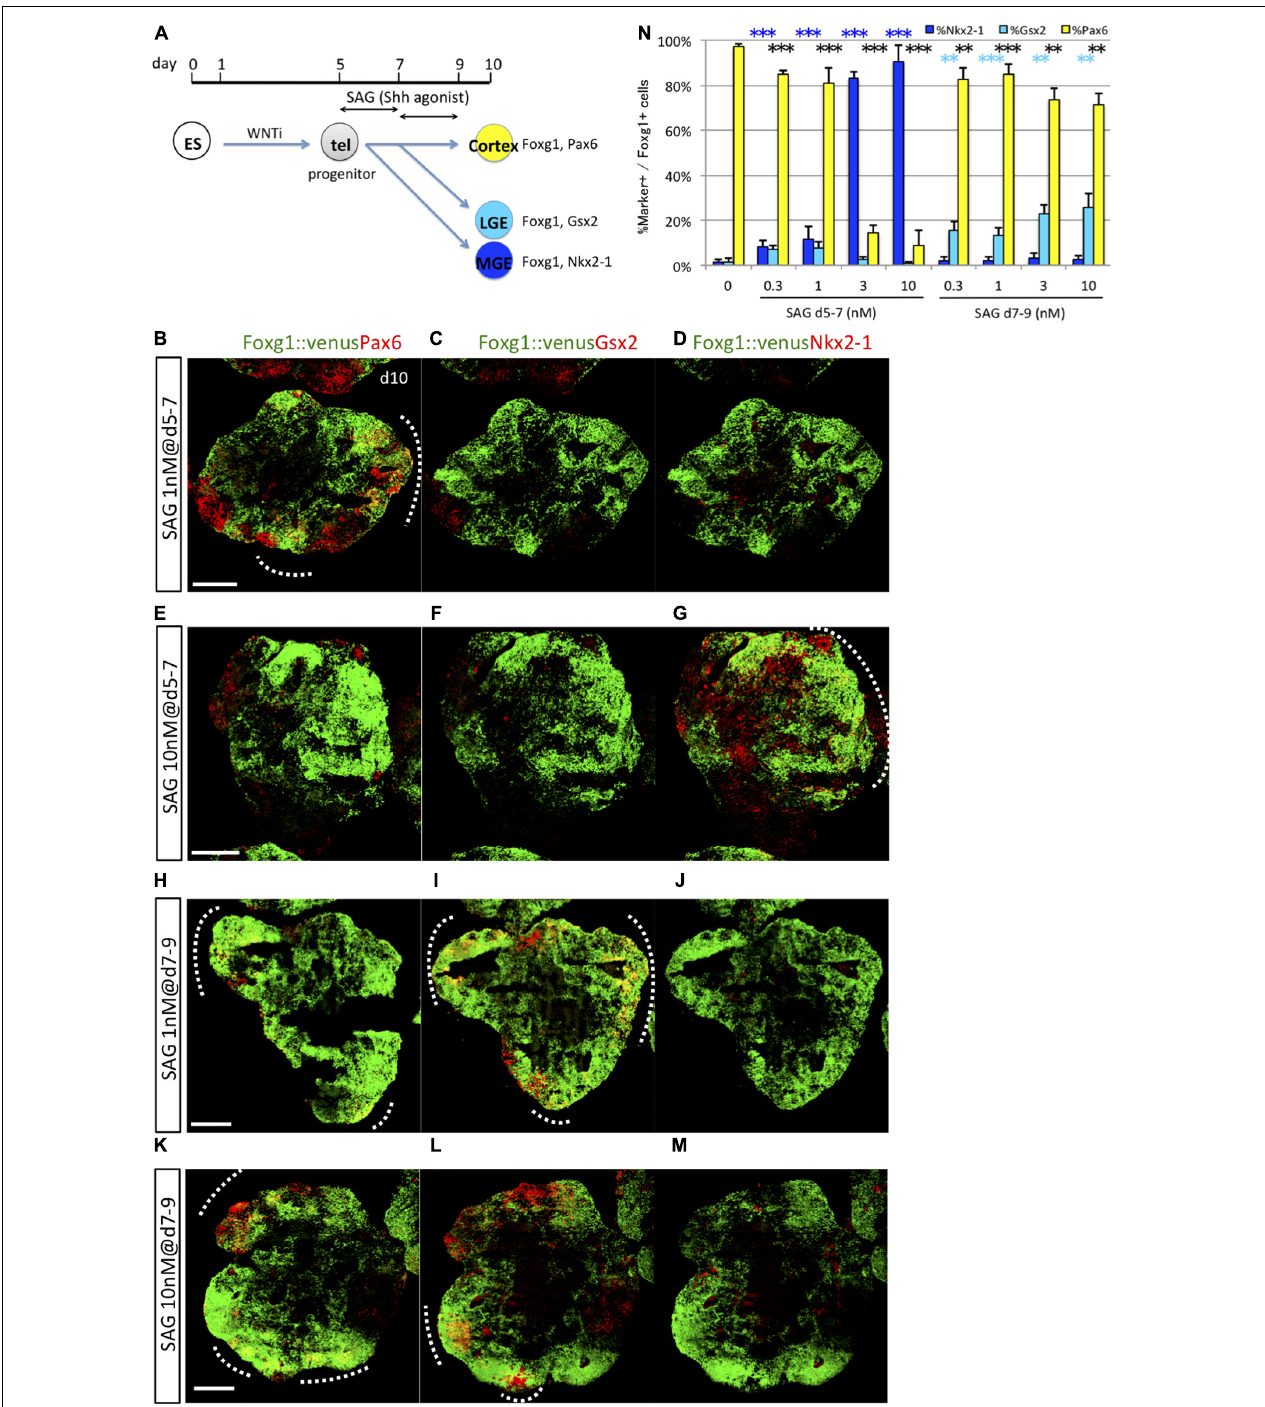
FIGURE 4 | Dose-dependent induction of Nkx2-1 and dose-independent induction of Gsx2. (A) Schematic of the 3D culture used to investigate dose-dependent subregional marker expression in two time windows, days 5–7 and 7–9. (B–M) Fluorescence images of serial sections through Foxg1::venus (telencephalic) cell aggregates (green) co-immunostained for subregional markers (red) Pax6 (B,E,H,K) , Gsx2 (C,F,I,L) , and Nkx2-1 (D,G,J,M) . A dashed line indicates an area with dual Foxg1 + /subregional marker + cells. Scale bars, 200 µ m. (B–D) Aggregates cultured with 1-nM SAG during days 5–7 post-seeding expressed Pax6 primarily. (E–G) Aggregates cultured with 10-nM SAG during days 5–7 expressed Nkx2-1 primarily. (H–M) Aggregates cultured with 1-nM ( H–J ) and 10-nM ( K–M ) SAG during days 7–9 expressed Pax6 and Gsx2 but little Nkx2-1. (N) Proportion (%) of subregional marker + cells among Foxg1 + cells; Pax6 + (yellow bars), Gsx2 + (cyan bars), and Nkx2-1 + (blue bars). SAG was added to the culture during days 5–7 or 7–9 at the following concentrations: 0 (none), 0.3, 1, 3, and 10 nM. Results expressed as mean ± SEM ( N = 4). ∗∗ P < 0.01, ∗∗∗ P < 0.001.